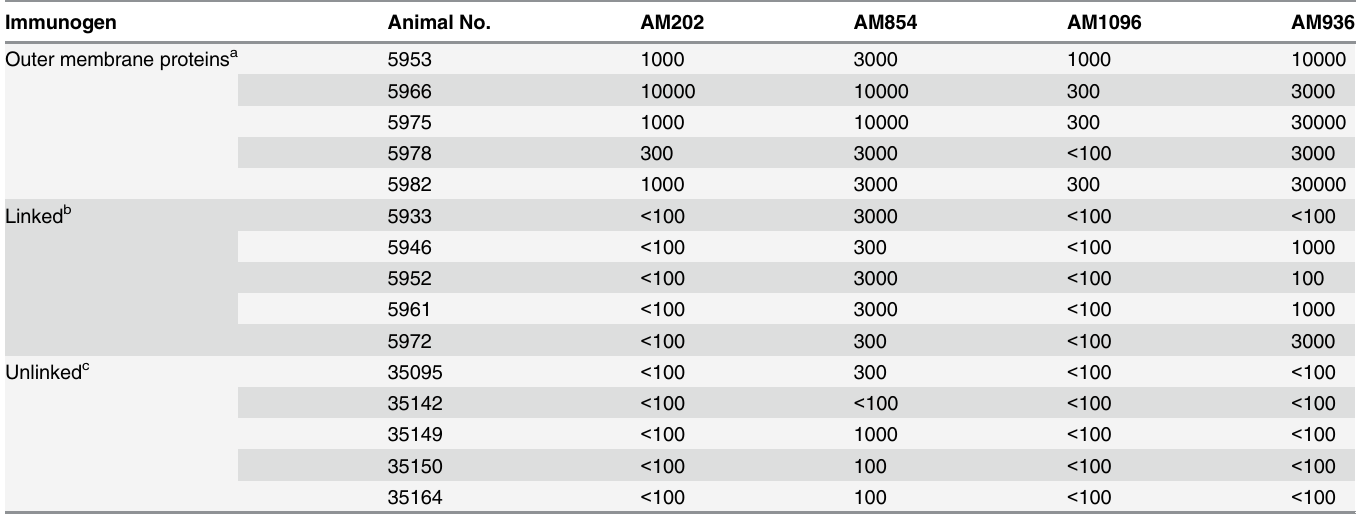
a. Titers in outer membrane protein vaccinates shown to protected from challenge. b. Titers in linked surface protein complex vaccinates shown to be protected from challenge. c. Titers in unlinked surface protein complex vaccinates shown to be protected from